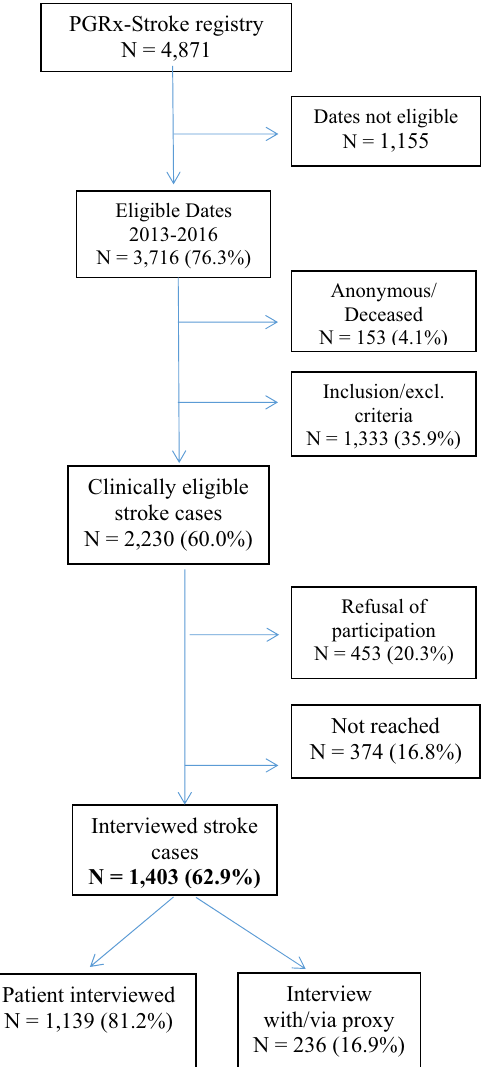
Figure 1. Flow chart of patient identification for the analyses conducted in the present case-crossover study. Abbreviations: ACS, acute coronary syndrome; MI, myocardial infarction.